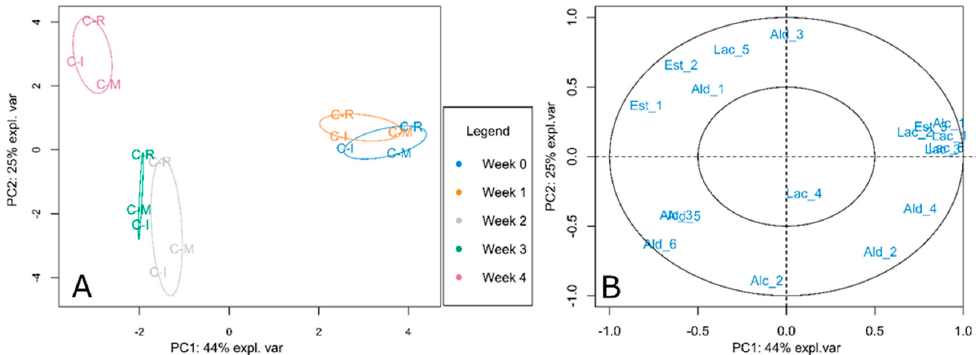
Figure 2. ( A ) Two-dimensional principal component analysis (PCA), elaborated using the VOCs quantified by the GC-MS at day 0 of simulated shelf-life for the three maturity classes (C-I: immature; C-M: mature; C-R: ripen. The ellipse confidence level is set at 0.5 (50% region). ( B ) Variable plot projecting the variables (VOCs) identified at day 0 of simulated shelf-life. VOCs ID is reported in Table 1. Two circumferences of radius 1 and 0.5 are plotted to report the correlation structure of the variables.